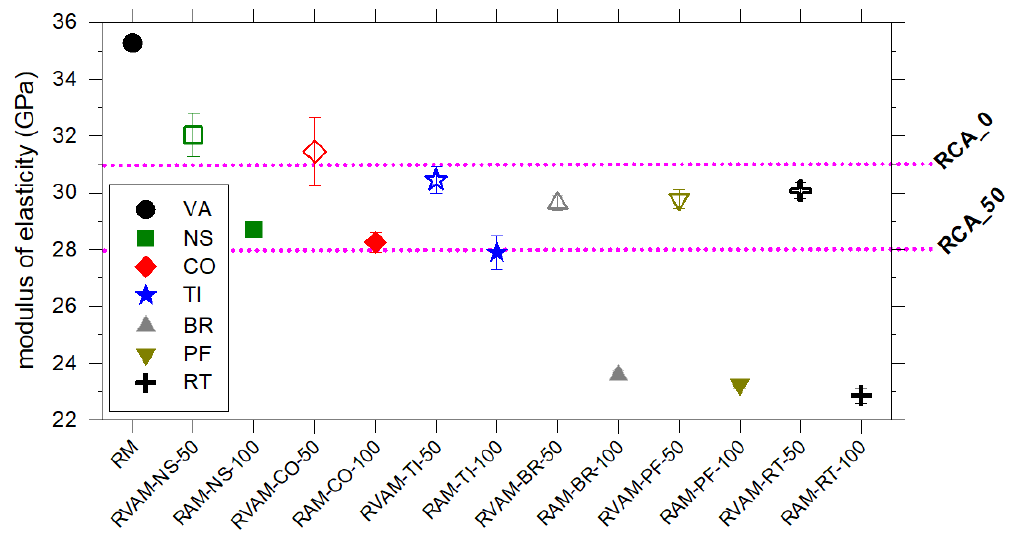
Figure 6. Variation of modulus of elasticity for RM, RVAM (empty symbols) and RAM (filled symbols). The horizontal pink lines correspond to the modulus of elasticity of RACs prepared with normal strength RCAs and VAs in the fraction of 0 and 100 wt.% (RCA_0) and 50 and 50 wt.% of RCA and NA (RCA_50), as reported in [27]